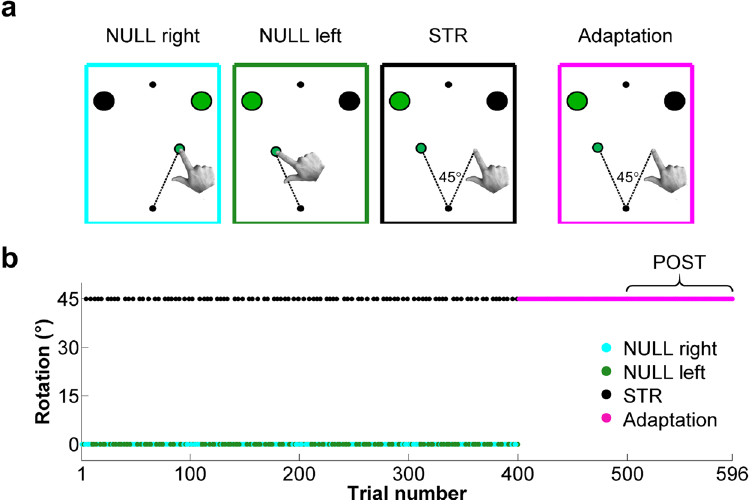
Figure 1. Experimental conditions and perturbation schedule. ( a ) Visual representation of the hand and cursor displacement during NULL right (cyan), NULL left (green), STR (black) and adaptation (magenta) trials. ( b ) Angle of visuomotor rotation throughout the experiment. During the first 400 trials, each pair of STR trials was interspersed by at least 2 NULL (right or left) trials. Visuomotor rotation was continuously present during the final 196 trials, the last 96 of which were binned as the post-adaptation (POST)